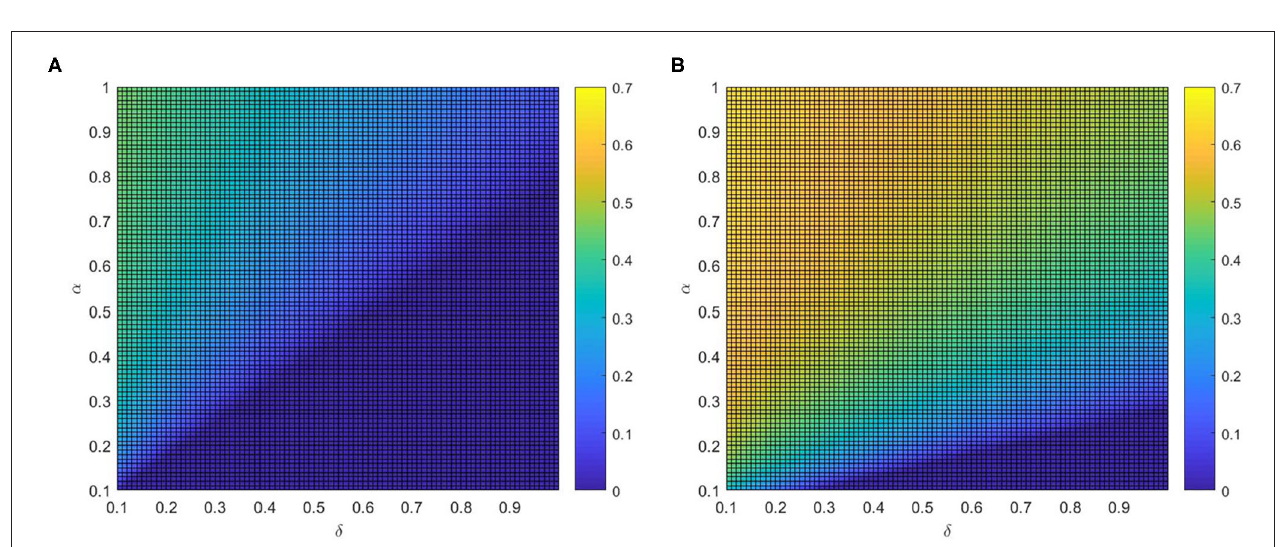
FIGURE 7 | The fraction ρ V of vaccinated individuals in the stationary state, where ε = 0.05, λ = 0.2 and ρ = 0.05. (A) α = 0.2 and (B) α = 0.8.